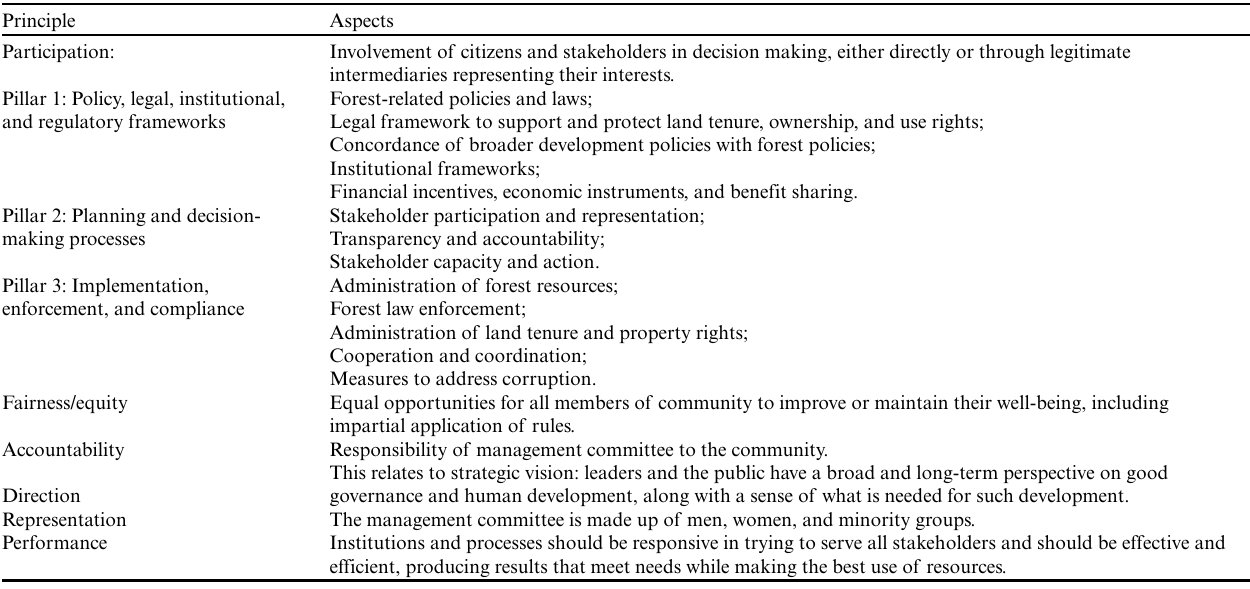
Table 1 . Modified common framework for assessing and monitoring forest